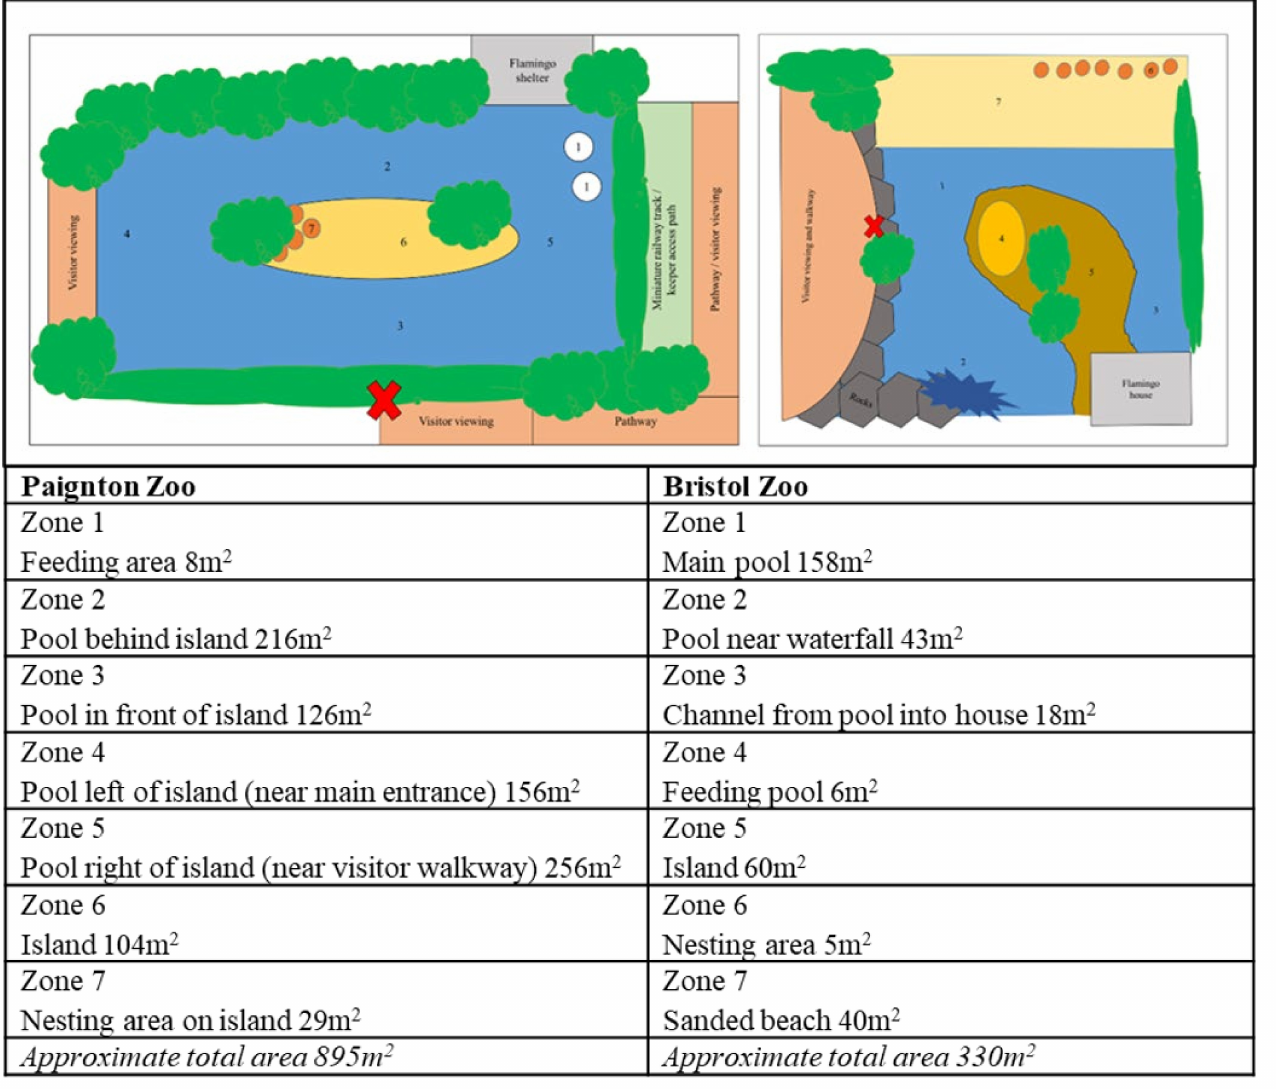
Figure 1. Approximate enclosure sizes and zones within each exhibit for the two zoos included in the study (not to scale). The red cross denotes the position of the observer. White areas of the image are all outside the flamingo enclosure. Only flamingo houses and numbered zones were accessible to the birds. Figure taken from Rose et al.